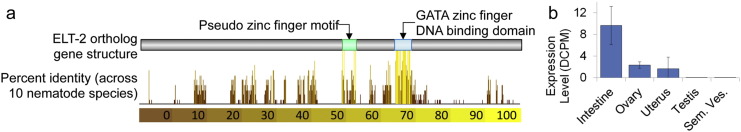
Conservation and expression level of the ELT-2 gene. (a) ELT-2 like protein domain architecture and its overall sequence conservation from the 10 nematode species. (b) Expression profile of the ELT-2 like gene in A. suum (GS_05212).